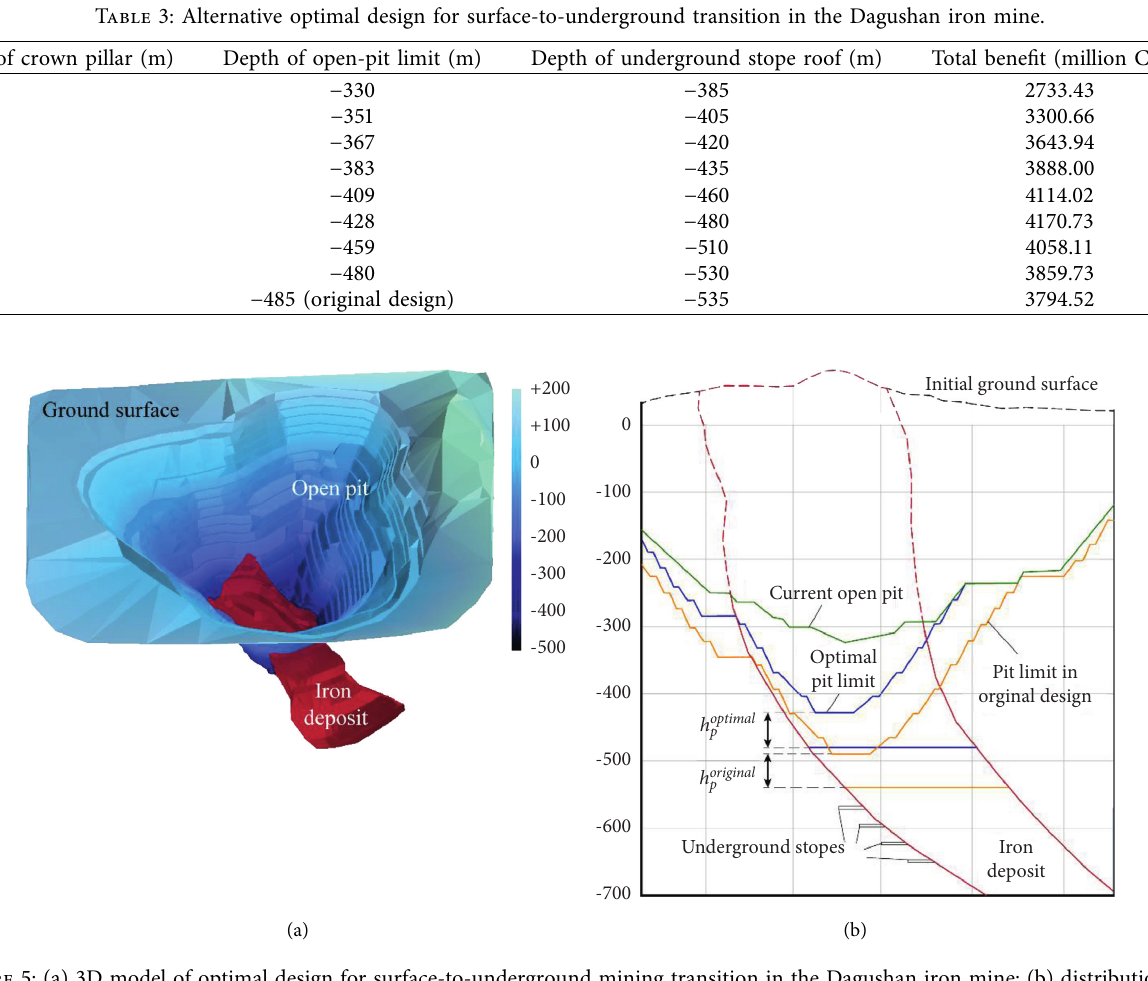
Figure 5: (a) 3D model of optimal design for surface-to-underground mining transition in the Dagushan iron mine; (b) distribution of current open pit, optimal and original design for surface-to-underground mining transition by the proposed approach and conventional UPL methodology, in a cross-section of the iron deposit. Note. (1) h optimal p and h orginal p are the size of the crown pillar in the optimal and original designs, respectively. (2) The iron deposit illustrated in Figure 5(a) provides the current shape, which is the same as the deposit in Figure